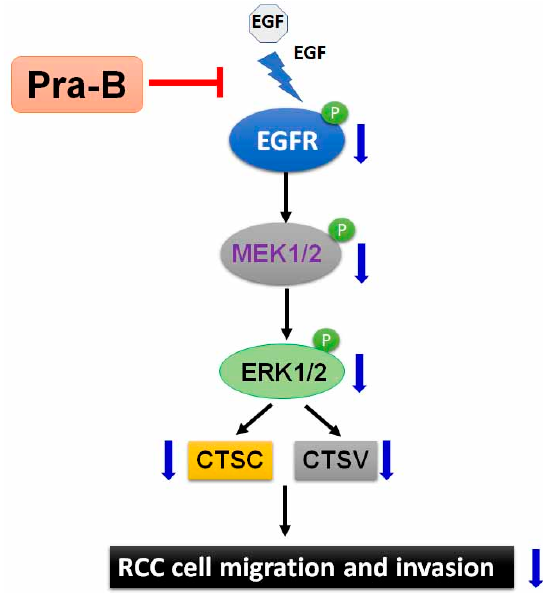
Figure 6. Illustration of how Pra-B inhibits the migration and invasion of human RCC cells through suppressing EGFR–MEK–ERK activation depending on CTSC and CTSV expression.